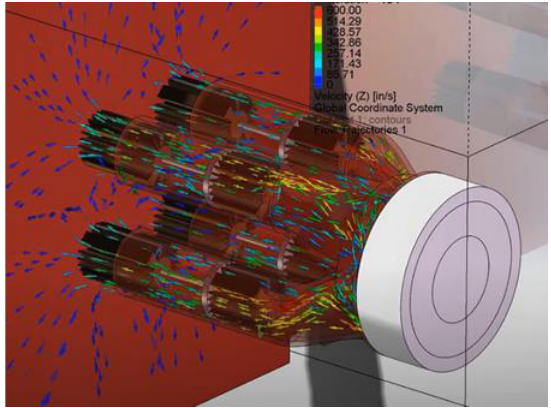
Figure 6: Computation Fluid Dynamics (CFD) Simulation of Four-Way Duct